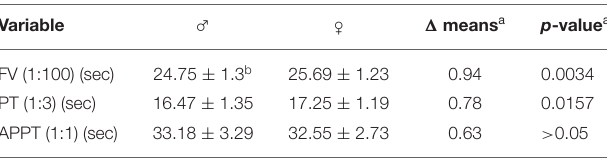
TABLE 2 | Sex-based measurements of factor V levels, prothrombin time and activated partial thromboplastin time. Variable